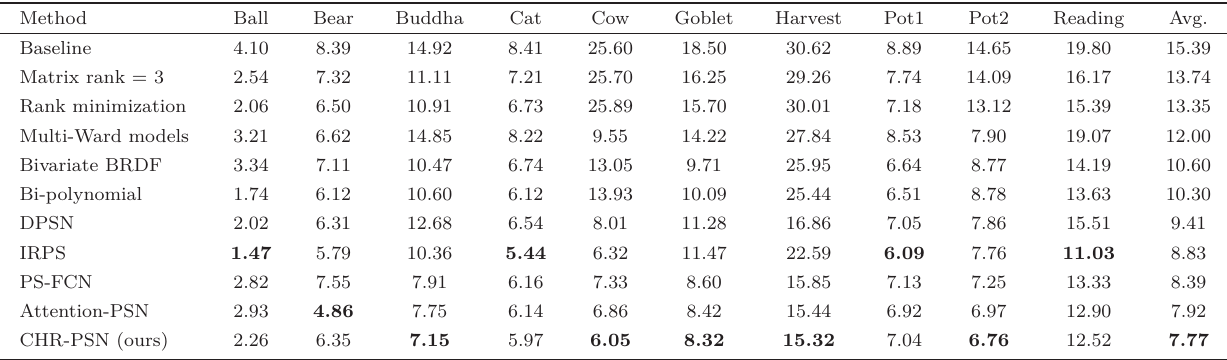
Table 2 MAE (in degree) for different methods on the DiLiGenT benchmark. All methods were evaluated with 96 images